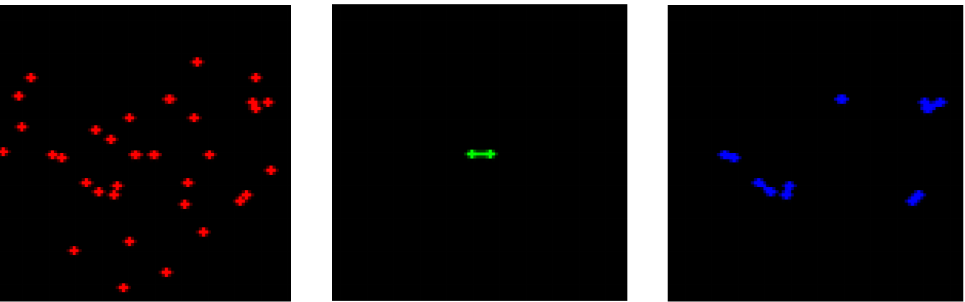
Figure 5. Example of input image. The vertices in the local view are in the red channel, the l edge is drawn in green channel, while the edges in the partial solution are in the blue